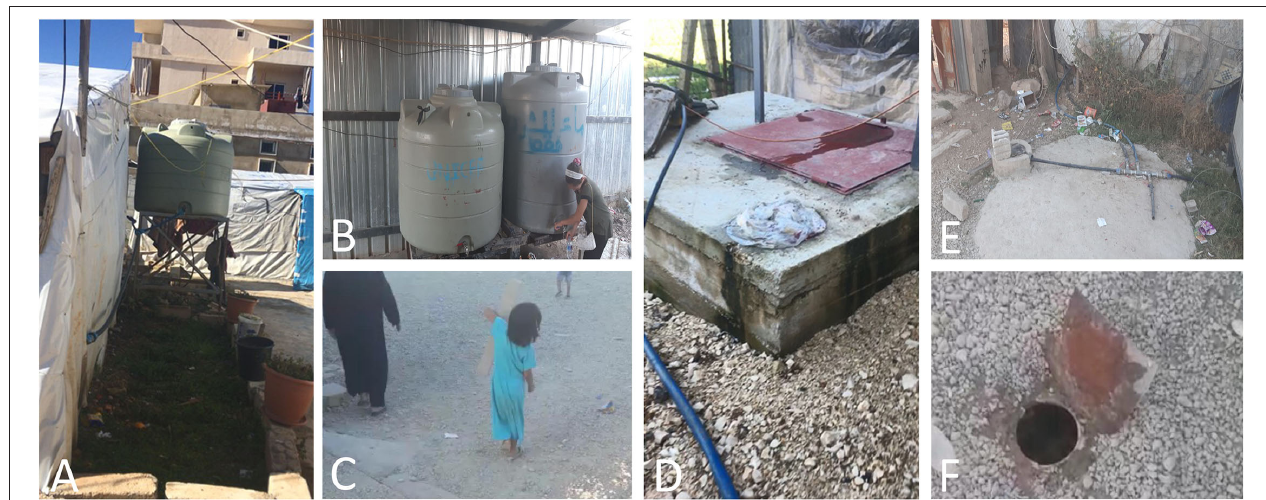
FIGURE 1 | Photographic examples highlighting the conditions in refugee camps in Lebanon. White makeshift tents in proximity to hosting community residence (concrete building in the background) (A) and limited-capacity water cisterns (A,B) that provide domestic and drinking water to the camp inhabitants that include a large number of youths (B,C) and elderly individuals (C) . The cisterns are filled periodically via water trucks provided by non-governmental organizations (NGOs) and charitable donations. The source of the water varies, the supply is sporadic, and the cisterns are filled from underground cisterns/wells (D,E) when the trucked water supply is insufficient. The underground cisterns are very vulnerable (without proper protection) and prone to contamination from shallow and inappropriate camp sewage conduits (F) , especially after rainfall. The camp inhabitants have reported that the cisterns have been contaminated with sewage on multiple occasions. This spreads persistent contamination to drinking and domestic water cisterns. Camp environments are generally unclean (dust, stones, solid waste) as can be observed in all the pictures above. Photographs were documented by Mr. Abdallah AlHaj